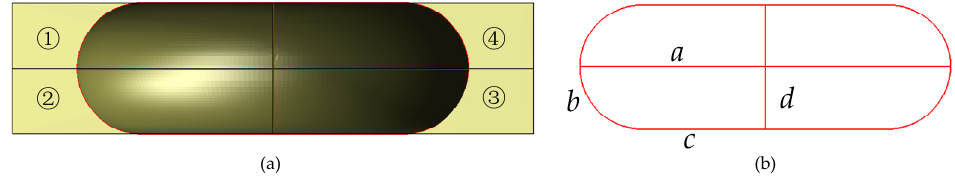
Figure 5. The top view of formed subspaces: ( a ) the top view of the complete subspaces; ( b ) the top view of the divided contour polylines. Table 1. Initial coding table after cutting polylines with the approximate planes.